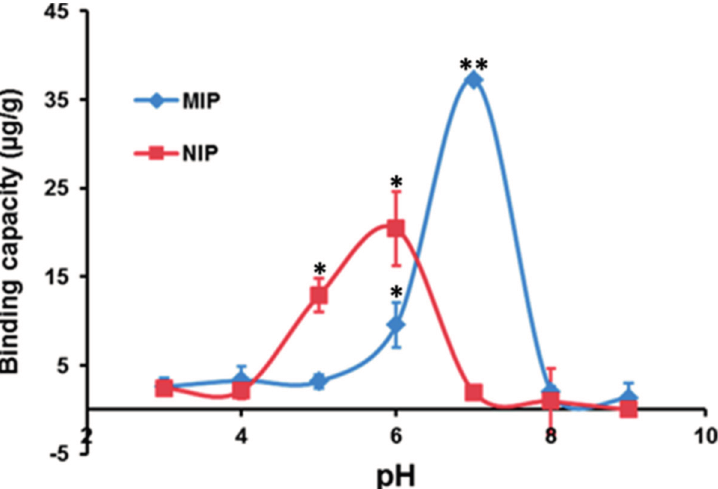
Figure 4. The effect of pH towards the sorption of Hg(II) for the MIP and NIP material (studies were carried out by taking 10 mg of MIP and NIP at a 25 °C). The results are expressed as the mean ± SD of the individual experiments; * and ** indicate the significance at p < 0.05 and p < 0.01 versus the